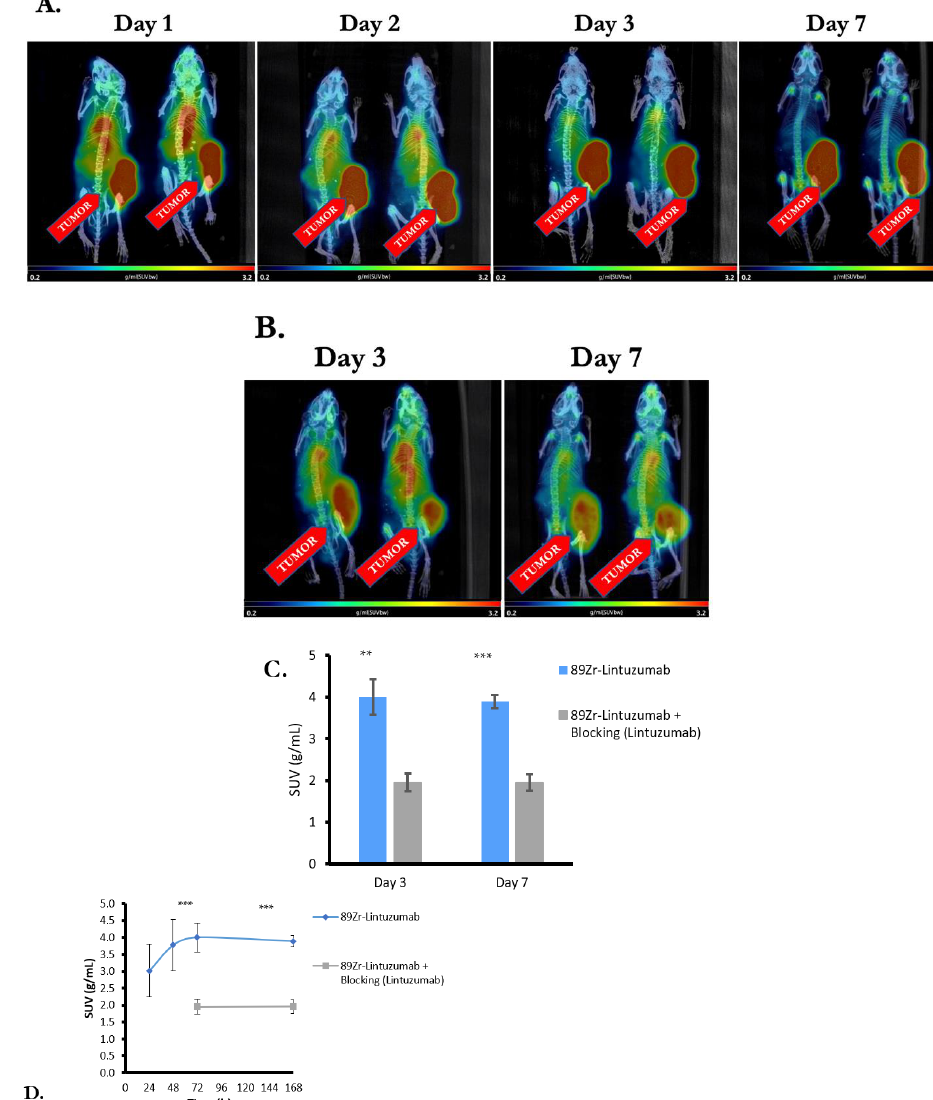
Figure 2. 89 Zr-lintuzumab Selectively Accumulates in CD33 Expressing Tumors. ( A ) PET/CT imaging of mice administered with 5.55 MBq 89 Zr-DFO-Lintuzumab only ( n = 4). Images were taken on Days 1, 2, 3, and 7 post administration. The radioconjugate was cleared from blood and other organs except for the tumor after Day 1 and accumulated in CD33-positive OCI-AML-3 tumors. ( B ) Cohort of mice ( n = 4) pre-blocked with cold Lintuzumab 24hr prior to administration of radioconjugate. PET/CT images were taken on Days 3 and 7 post radioconjugate administration. The clearance of radioconjugate from blood and other organs in mice pre-blocked with Lintuzumab was not as effective as in non-blocked mice: radioactivity was detected in various organs by PET/CT imaging even on Day 7 post administration. ( C ) Standardized uptake values (SUV) analysis of PET/CT images taken on Days 3 and 7. Tumor volumes of interest (VOI) were drawn, and SUV were calculated. than in the tumors of pre-blocked mice. ( D ) Time–activity curves (TAC) show that the radiolabeled antibody remains mostly constant over the 7-day period after initial uptake for both non-blocked and pre-blocked tumors, with the pre-blocked has significantly less uptake. All images are displayed as maximum intensity projections (MIP). ** and *** mean p = 0.001 and p < 0.0001,